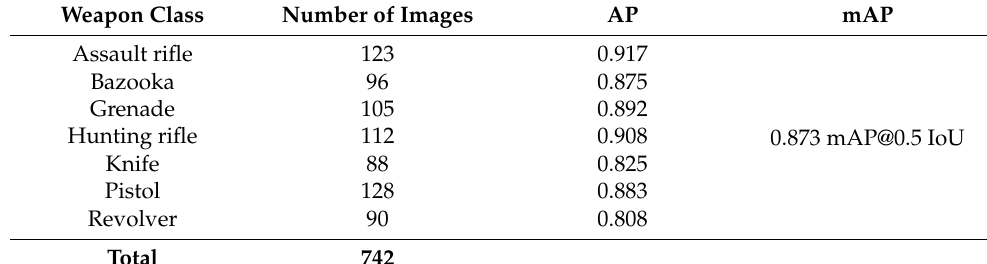
Table 4. Mean average precision (mAP) of the weapon images used in the dataset.